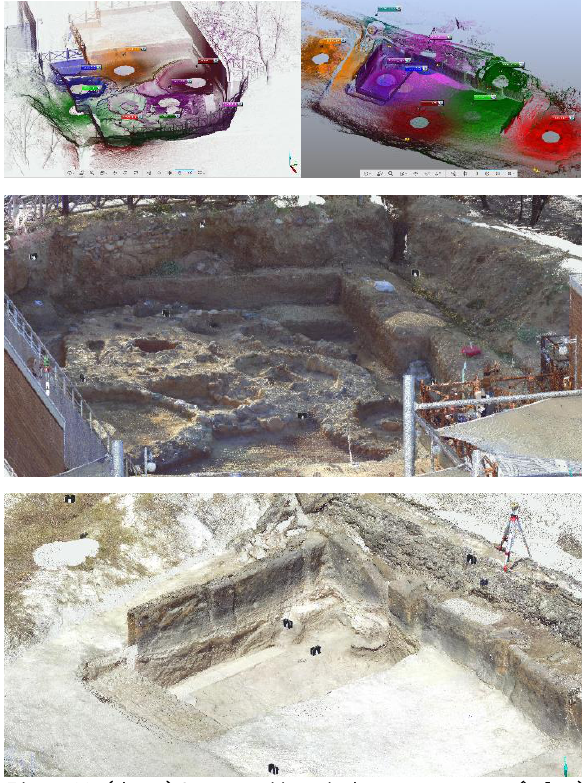
Figure 11. (above) Scans positions in the two test areas; (below) dense clouds of test areas. Figure 10. (left) The terracotta paving decorated slabs (from 4 mm resolution orthoimage) (right) A 3D view of the multiscale integrated DSM.